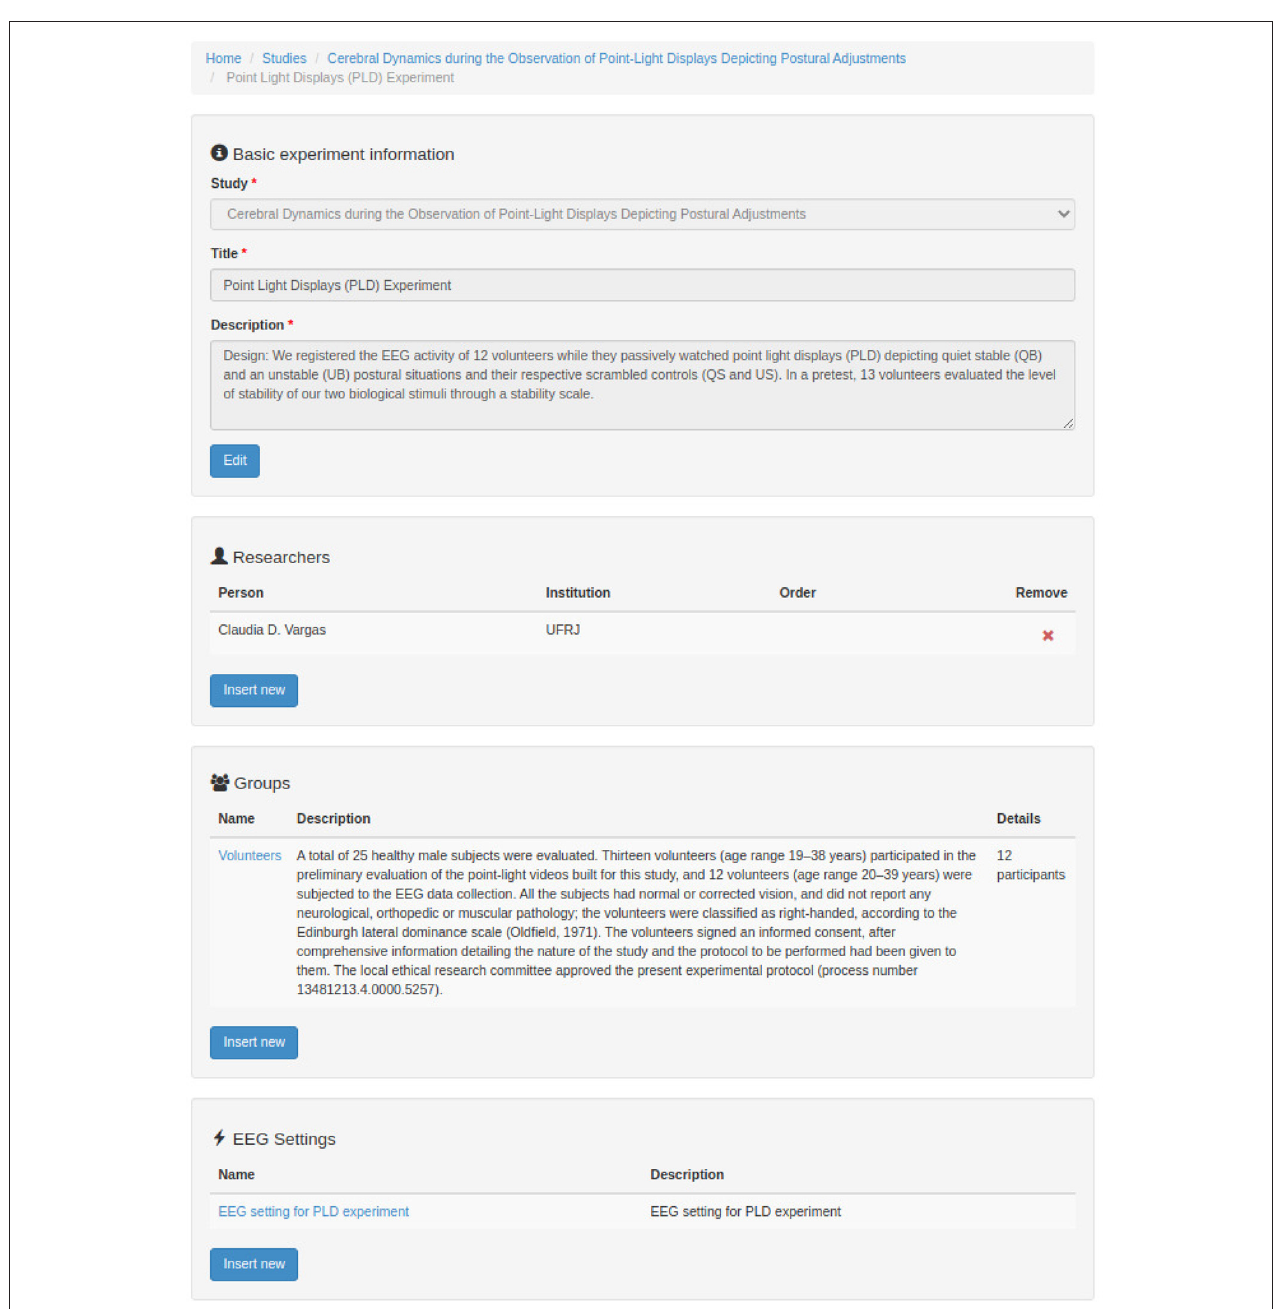
FIGURE 7 | NES graphical interface for registering the basic information about an experiment.